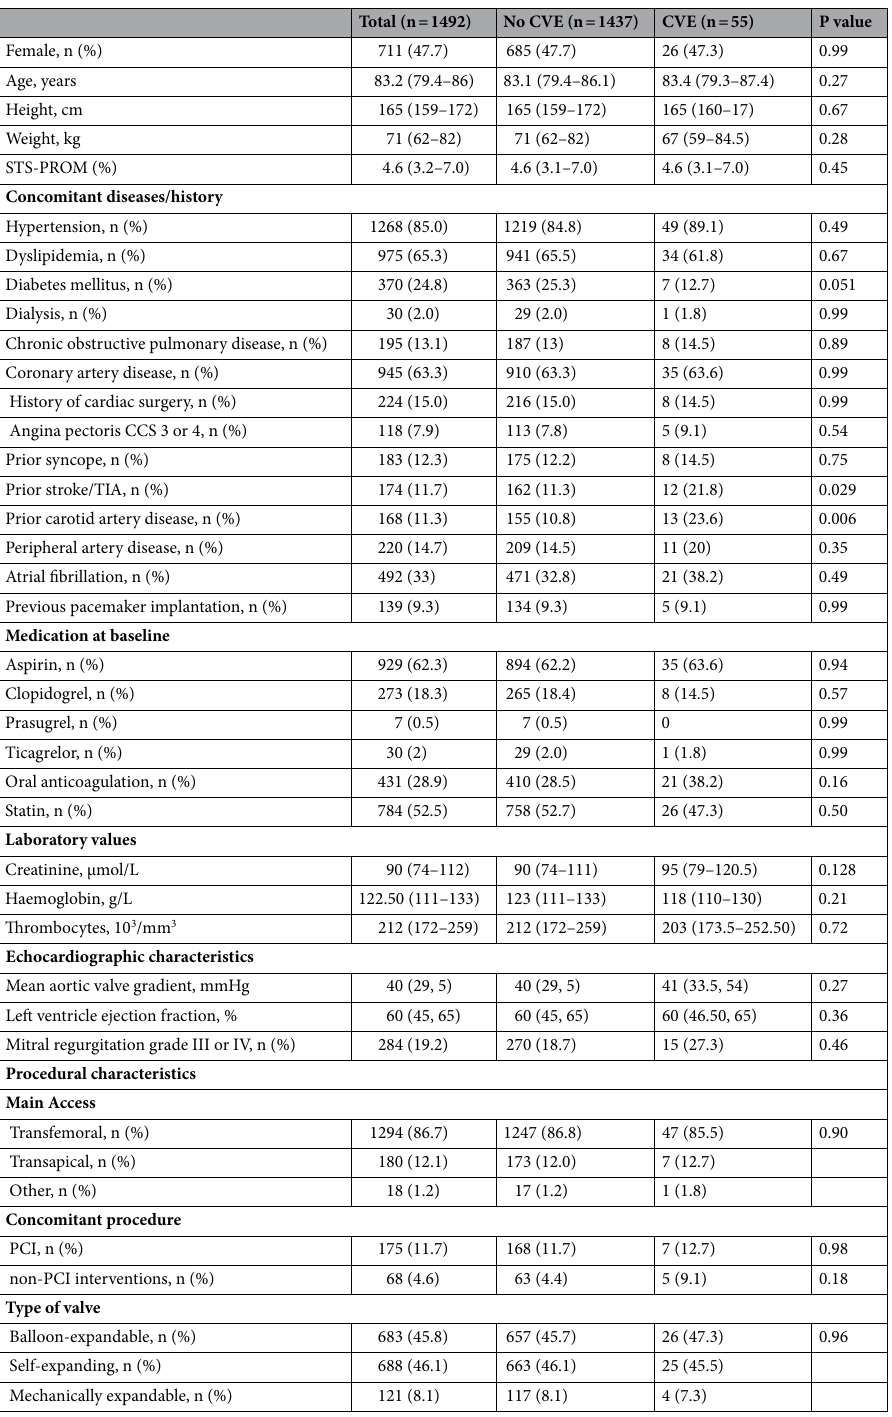
Table 1. Patient clinical characteristics by occurrence of cerebrovascular event within 30 days after TAVR. Balloon-expandable valves: SAPIEN, SAPIEN XT, or SAPIEN 3 (Edwards Lifesciences, Irvine, CA, USA). Self- expanding valves: CoreValve, Evolut R/PRO (Medtronic, Minneaplis, MN, USA), Portico (Abbott, Chicago, IL, USA), or Symetis ACU RAT E.ACU RAT E neo (Boston Scientific, Marlborough, MA, USA). Mechanically- expanding valves: Lotus (Boston Scientific, Marlborough, MA, USA). CCS Canadian Cardiovascular Society grading, CVE cerebrovascular event, PCI percutaneous coronary intervention, STS-PROM Society of Thoracic Surgeons Predicted Risk of Mortality, TIA Transient ischemic